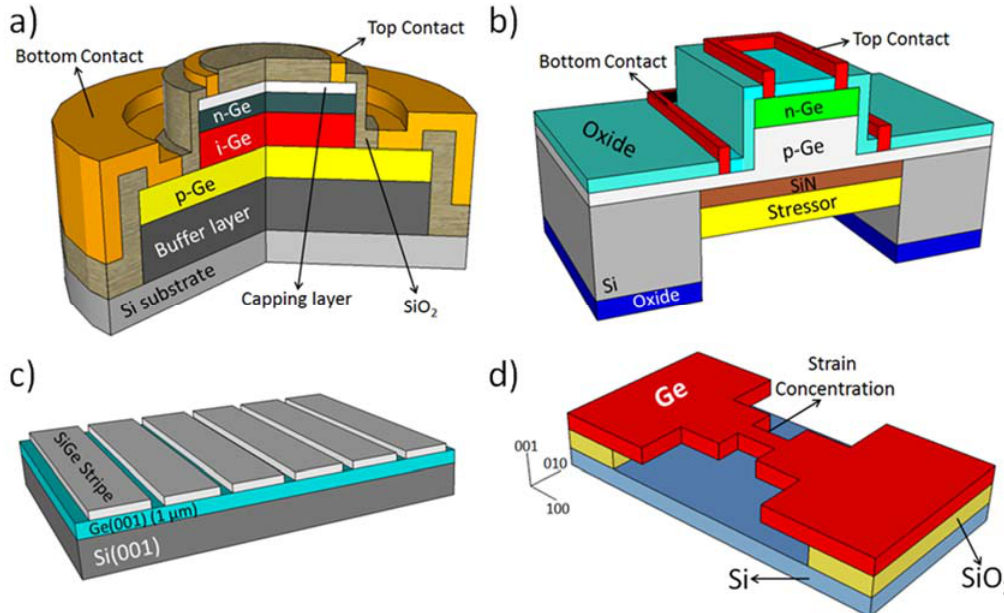
Figure 2. Strain engineering approaches. ( a ) Typical layout of Ge ‐ based LED and photodiode monolithically integrated on Si [49–53]. ( b ) Device obtained on highly strained Ge membranes. Adapted with permission from [77], Copyright AIP Publishing, 2012. ( c ) SiGe stripes patterned on a relaxed Ge layer directly grown on Si substrate. Adapted with permission from [78], Copyright AIP Publishing, 2015. (d ) Suspended microbridges obtained from underetching of Ge ‐ on ‐ insulator wafers. Adapted with permission from [80], Copyright AIP Publishing, 2016. Drawings not to scale.